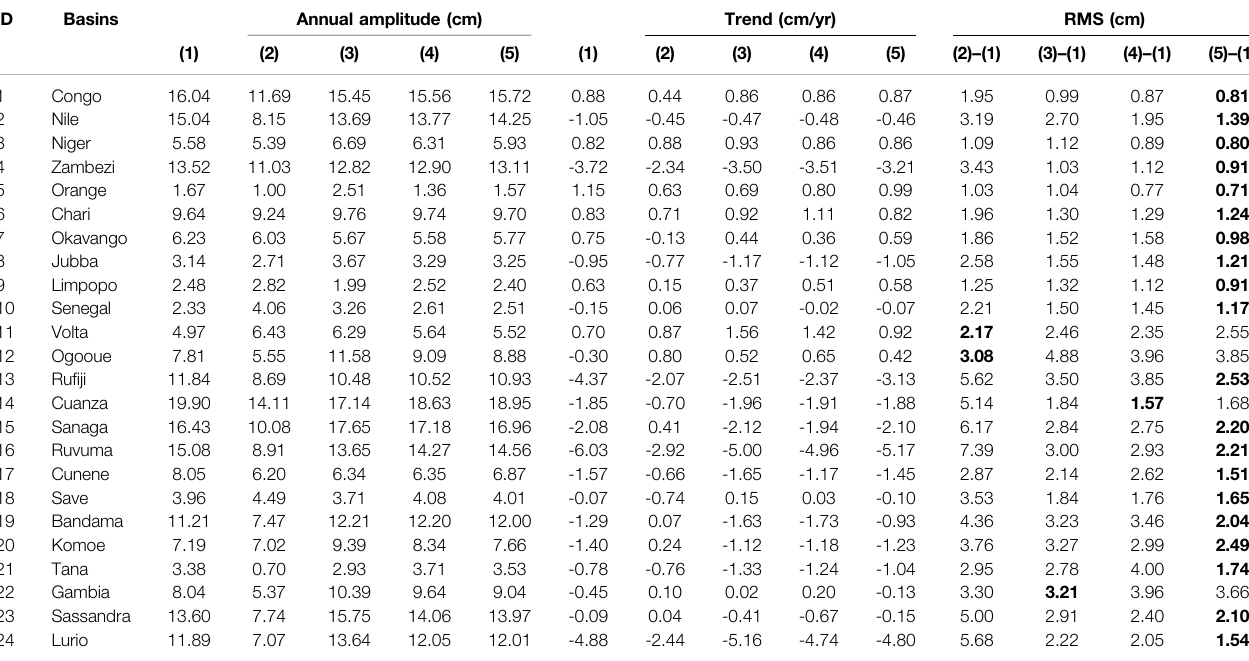
TABLE4| Annualamplitudes(cm),trends(cm/yr),andRMS(cm)of24basinsoverAfricaderivedfromdifferentprocessingprocedures:(1)truesignalsderivedfromESMHIS model;(2)simulatedGRACEdataafter500 kmGaussian fi ltering;(3)simulatedGRACEdataafterapplyinggeneralforward-modelingmethod;(4)simulatedGRACEdata after applying improved forward-modeling method; (5) simulated GRACE Follow-On data after applying improved forward-modeling method a